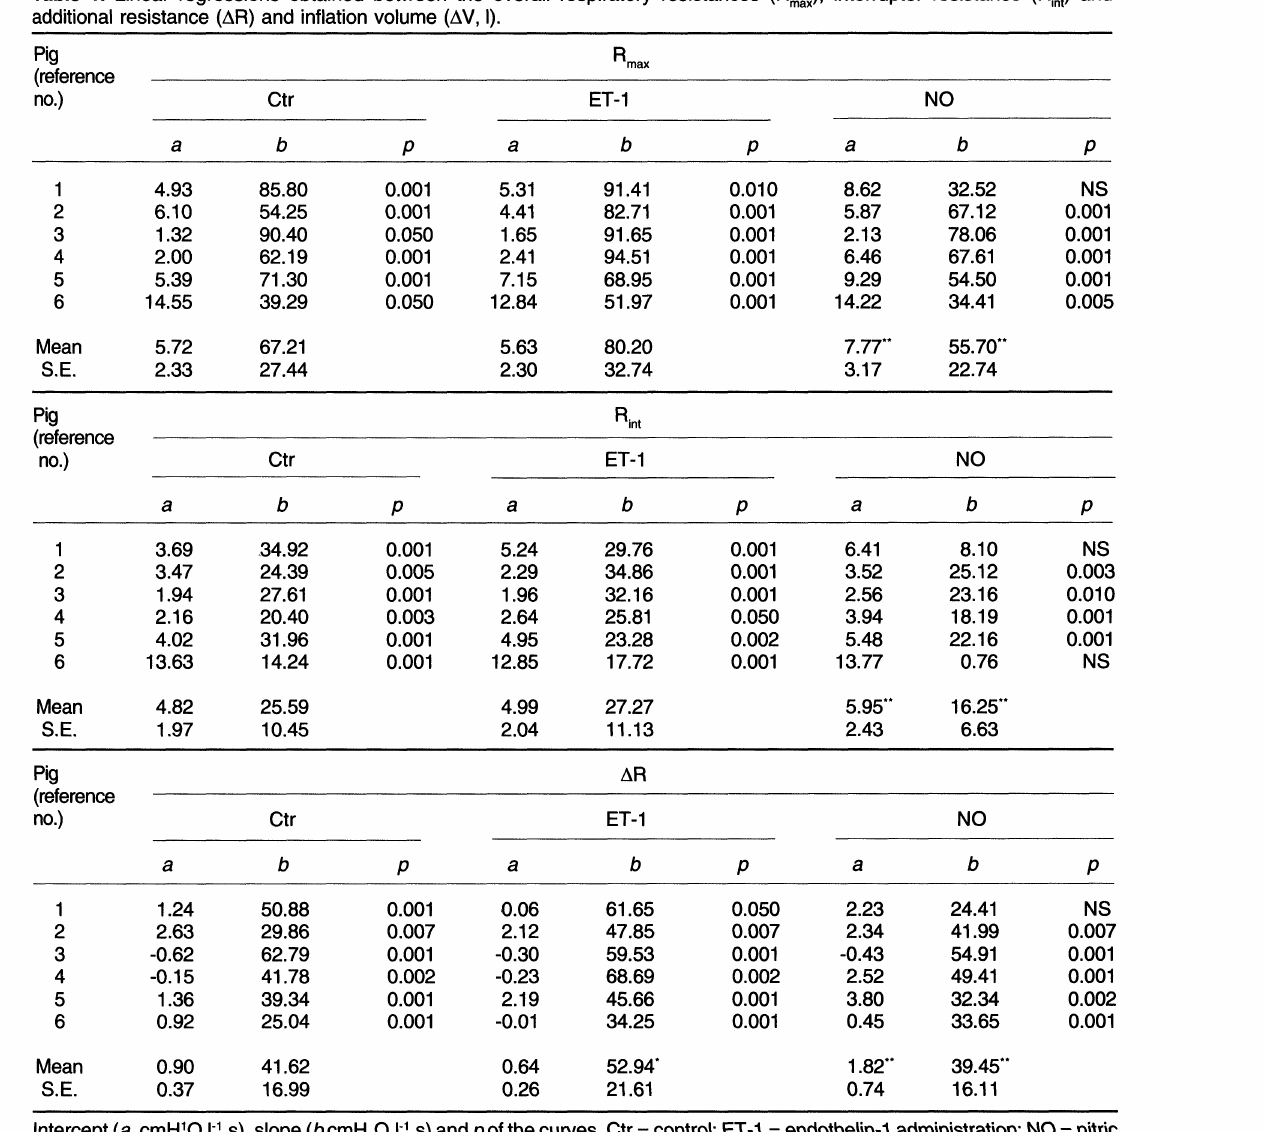
Table 1. Linear regressions obtained between the overall respiratory resistances (Rnax), interrupter resistance (R,t) and additional resistance (AR) and inflation volume (AV, I). Pig Rma (reference no.)